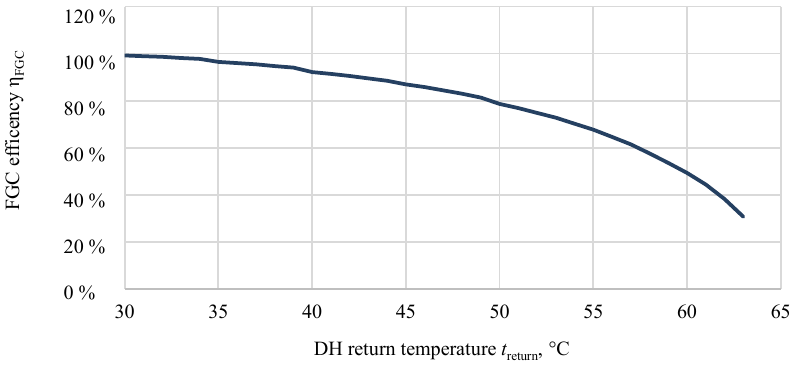
Fig. 4. FGC efficiency at different DH return temperatures.